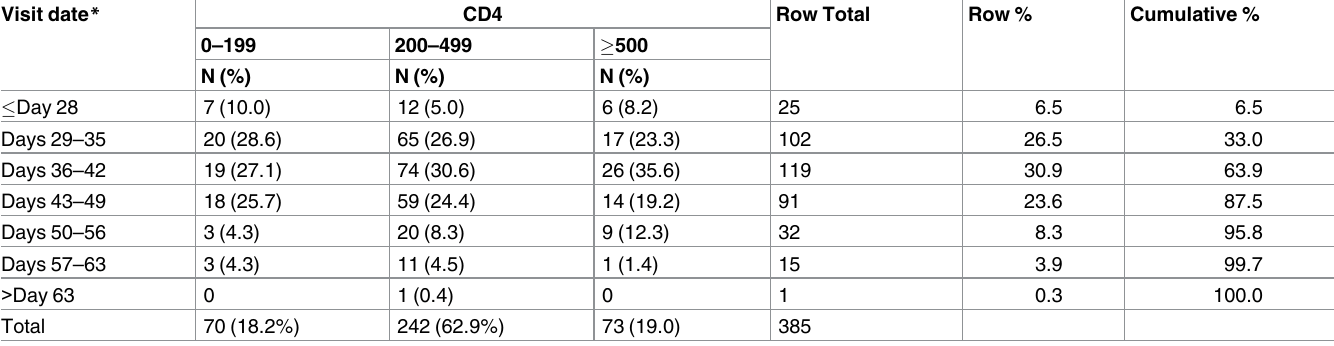
Table 3. Percent of men healed at each visit, by CD4 (N =